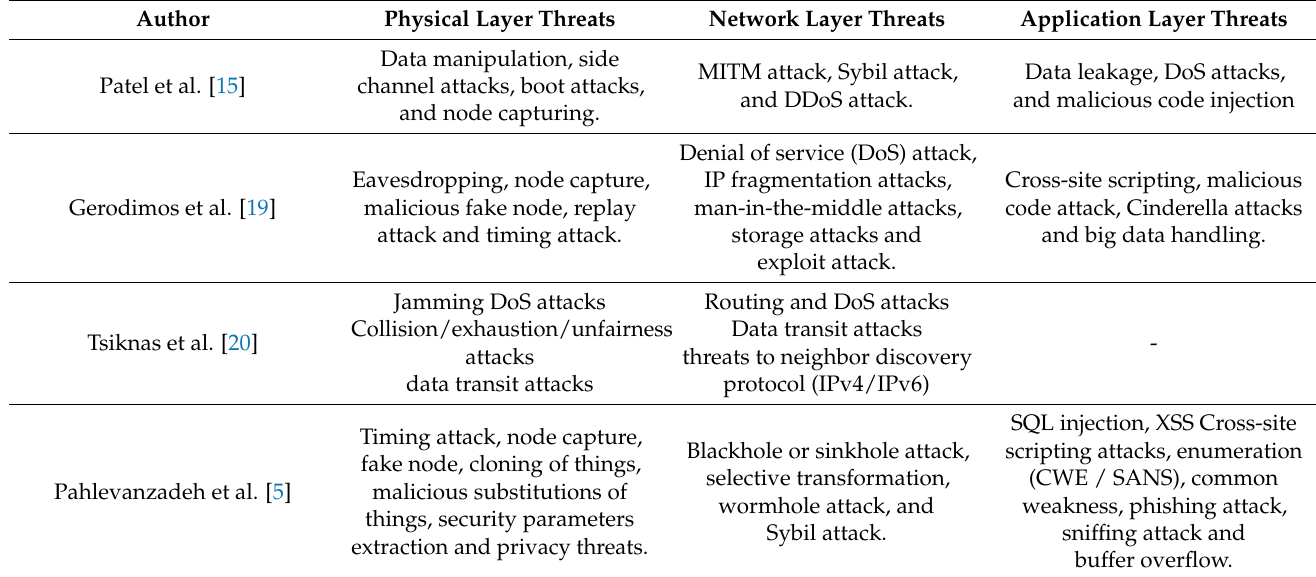
Table 5. Classify threats on each of three layers